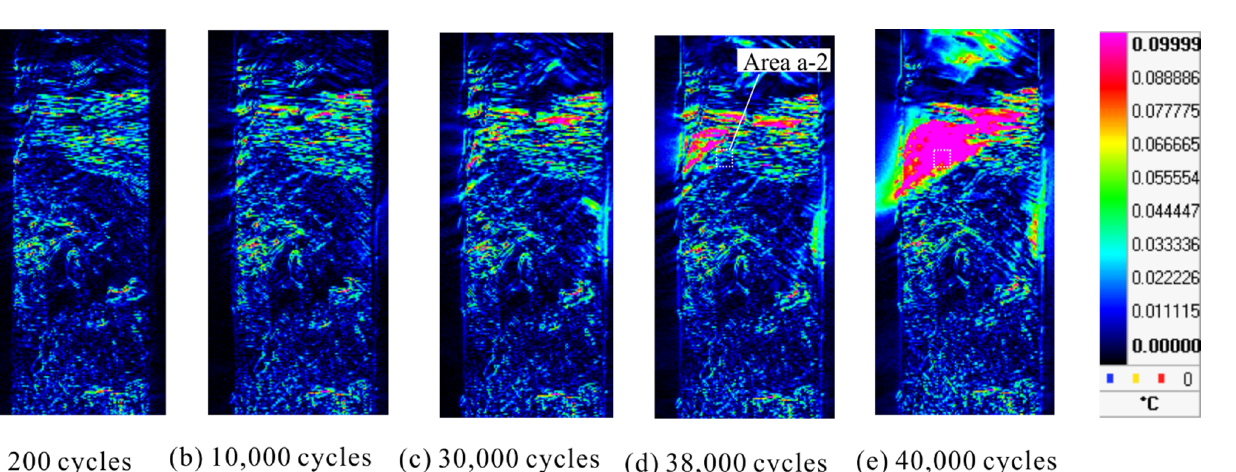
Figure 6. Temperature change and load signal in Area a-2. The constant stress amplitude fatigue test for another smooth specimen (Specimen B) was conducted at σ max = 180 MPa and R = 0.1. This specimen was broken at N f = 4.42 × 10 4 cycles. The distribution of the second-harmonic temperature component is shown in Fig- ure 7. It was found that some regions with high Δ T D appeared locally. Figure 8 shows the load and temperature signals at two points (Area b-1 and b-2) in Figure 7. In these regions, the load and temperature signals at N = 200 cycles are in phase, and the temperature change in Area b-1 is slightly distorted at the maximum tensile load, compared with that at the minimum tensile load. From Figure 8b, the temperature waveform at N = 4000 cycles (life ratio N/N f = 0.1) is further distorted than that at N = 200 cycles, and no temperature rise occurs above a certain stress magnitude. It was clarified that the distortion of temper- ature change appears at the maximum tensile load in both cases where the temperature signal is in the opposite phase and in phase with respect to the load signal. The change in the second-harmonic temperature component reflects the distortion of temperature change. It has been reported that the second harmonic component of the thermal signal is caused by the plastic deformation in metallic materials. The distortion of the temperature change and second harmonic temperature component in SCFRPs may be caused by the change in load sharing conditions between the fiber and resin due to delamination dam- age, the energy dissipation due to the plastic deformation in the resin, and/or the viscoe- lasticity of resin.